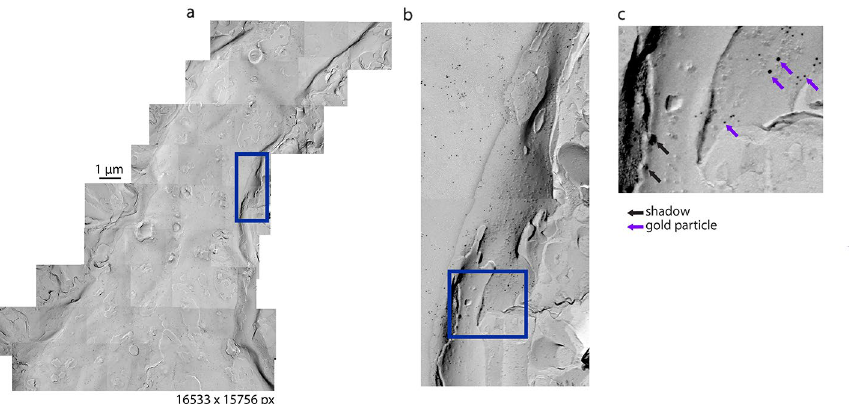
Figure 3. Difficulties of annotating gold particles in FRIL images ( a ) Sample FRIL profile obtained from a Purkinje cell dendrite. Blue box represents area in ( b ). ( b ) Sample area with membrane contours and shadows to illustrate difficulties for thresholding techniques. ( c ) Shadows and gold particles are often difficult to discern with their gray scale. FRIL images were collected from cerebellar tissue expressing Td-tomato-tagged channelrhodopsin2, and labeled with antibody-conjugated gold